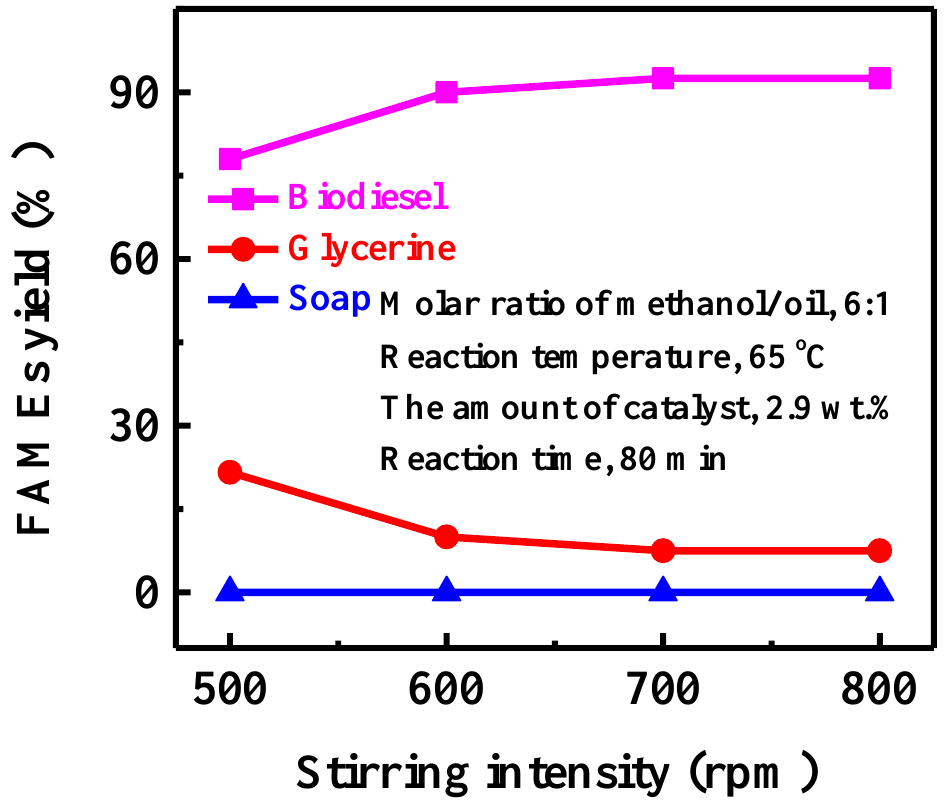
Figure 6. The effect of stirring intensity on RTOB yield. Figure 6. The e ff ect of stirring intensity on RTOB